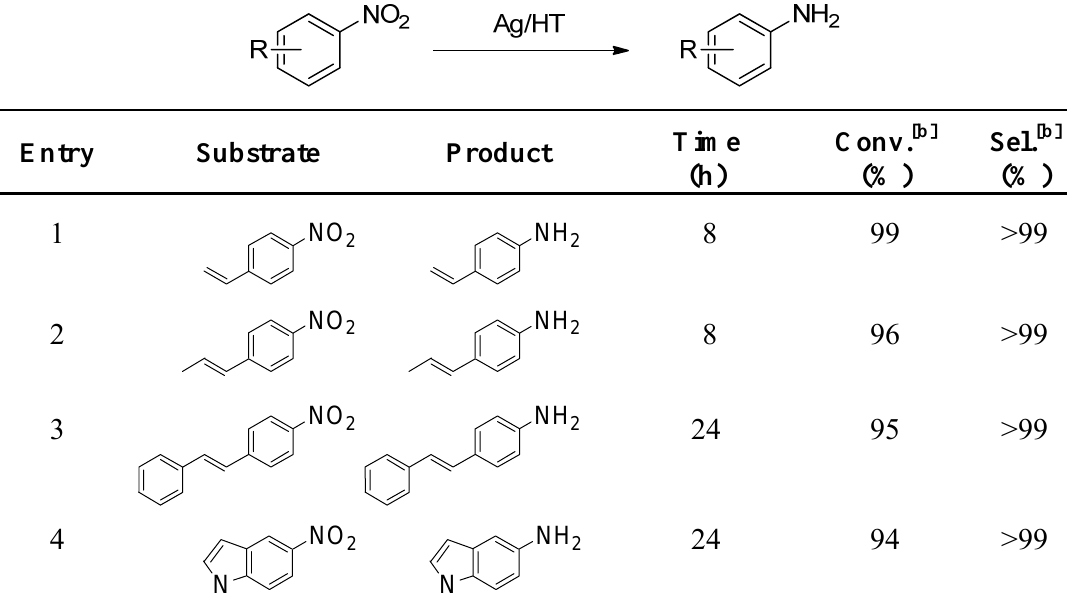
Table 7. Deoxygenation of Various Nitro Compounds by Ag/HT Using CO/H